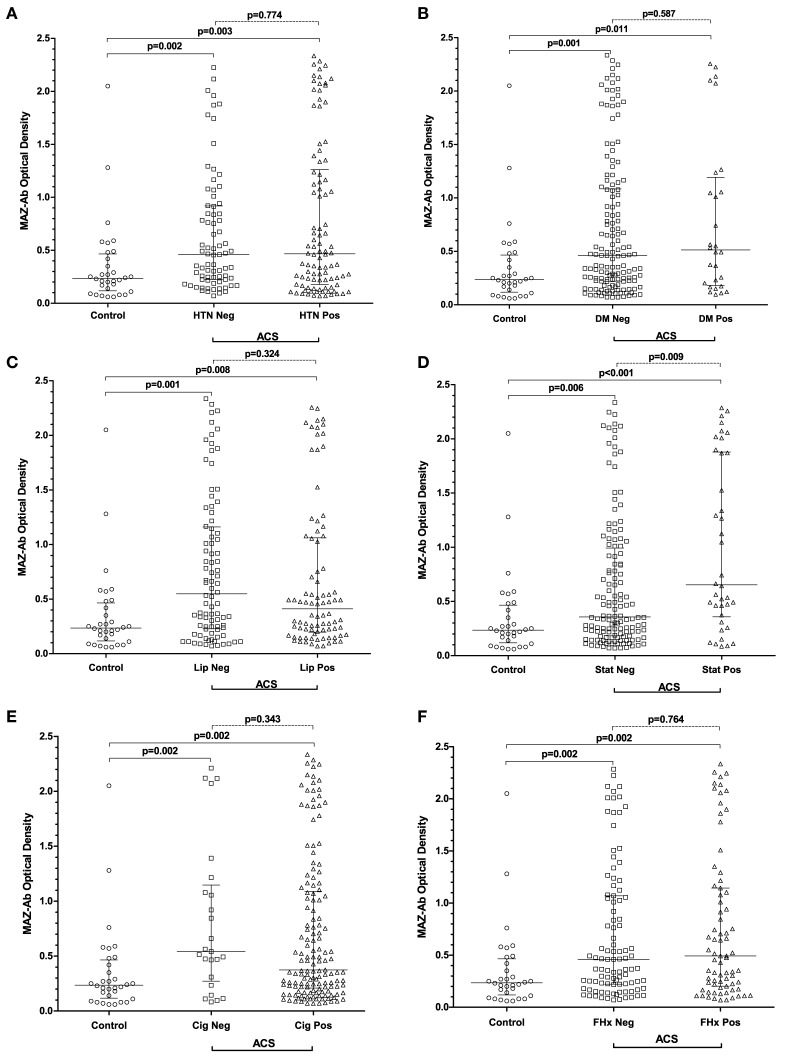
(A–F) Summarizing MAZ-Ab optical densities in all patients, with patients in the acute coronary syndrome (ACS) group being sub-classified on the presence or absence of specific cardiovascular risk factors. For all risk factors, MAZ-Ab optical densities were higher in ACS patients regardless of risk factor status compared with controls. Among ACS patients, only statin use resulted in a difference in MAZ-Ab optical density, with treated patients having higher values. Key: MAZ-Ab, MYC-associated zinc finger protein antibody; HTN, arterial hypertension; DM, diabetes mellitus; LIP, dyslipidemia; STAT, current treatment with HMG-CoA reductase inhibitors; Cig, any smoking history; FHX, any first-degree family history of cardiovascular disease.